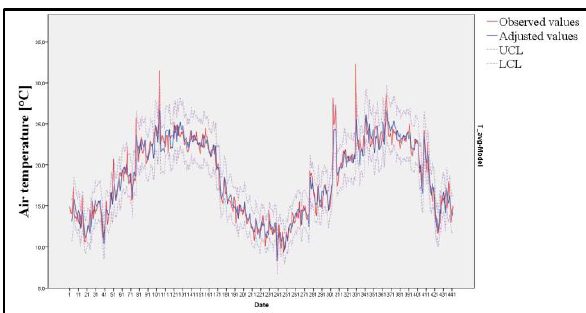
Figure 7. Time series curve of Tavg from 2011 to 2012 (UCL: Upper Control Limit; LCL: Lower Control Limit).